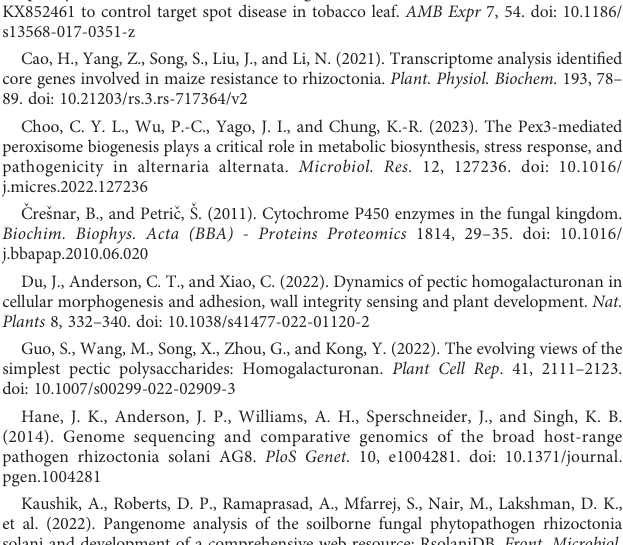
SUPPLEMENTARY TABLE 1 Summary of RNA-seq